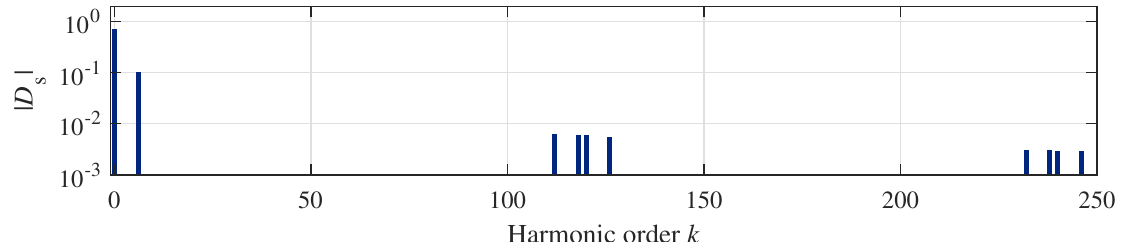
Figure 9. Spectrum of the sampled and held duty cycle with two components at k = 1 and k = 7. Due to sampling, components around multiples of the f c / f 0 = 60 are present